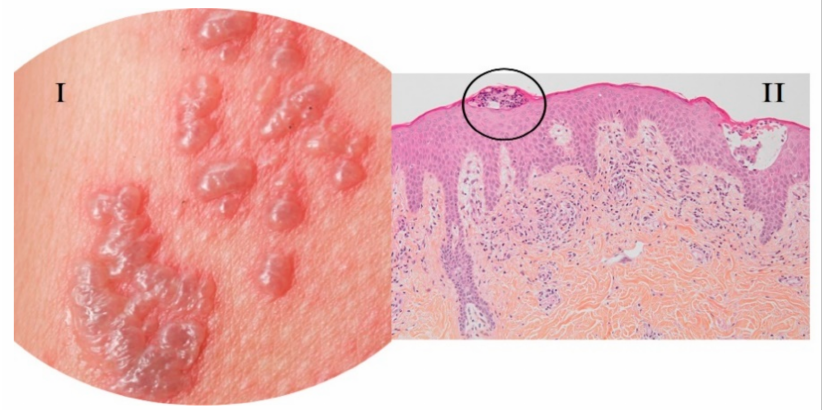
Figure 2. Vesicular lesions associated with COVID-19. ( I ) Vesicular eruptions associated with COVID-19; ( II ) skin biopsy with spongiotic vesicular eruption. HE × 10. Arias-Arguello A. (2020)